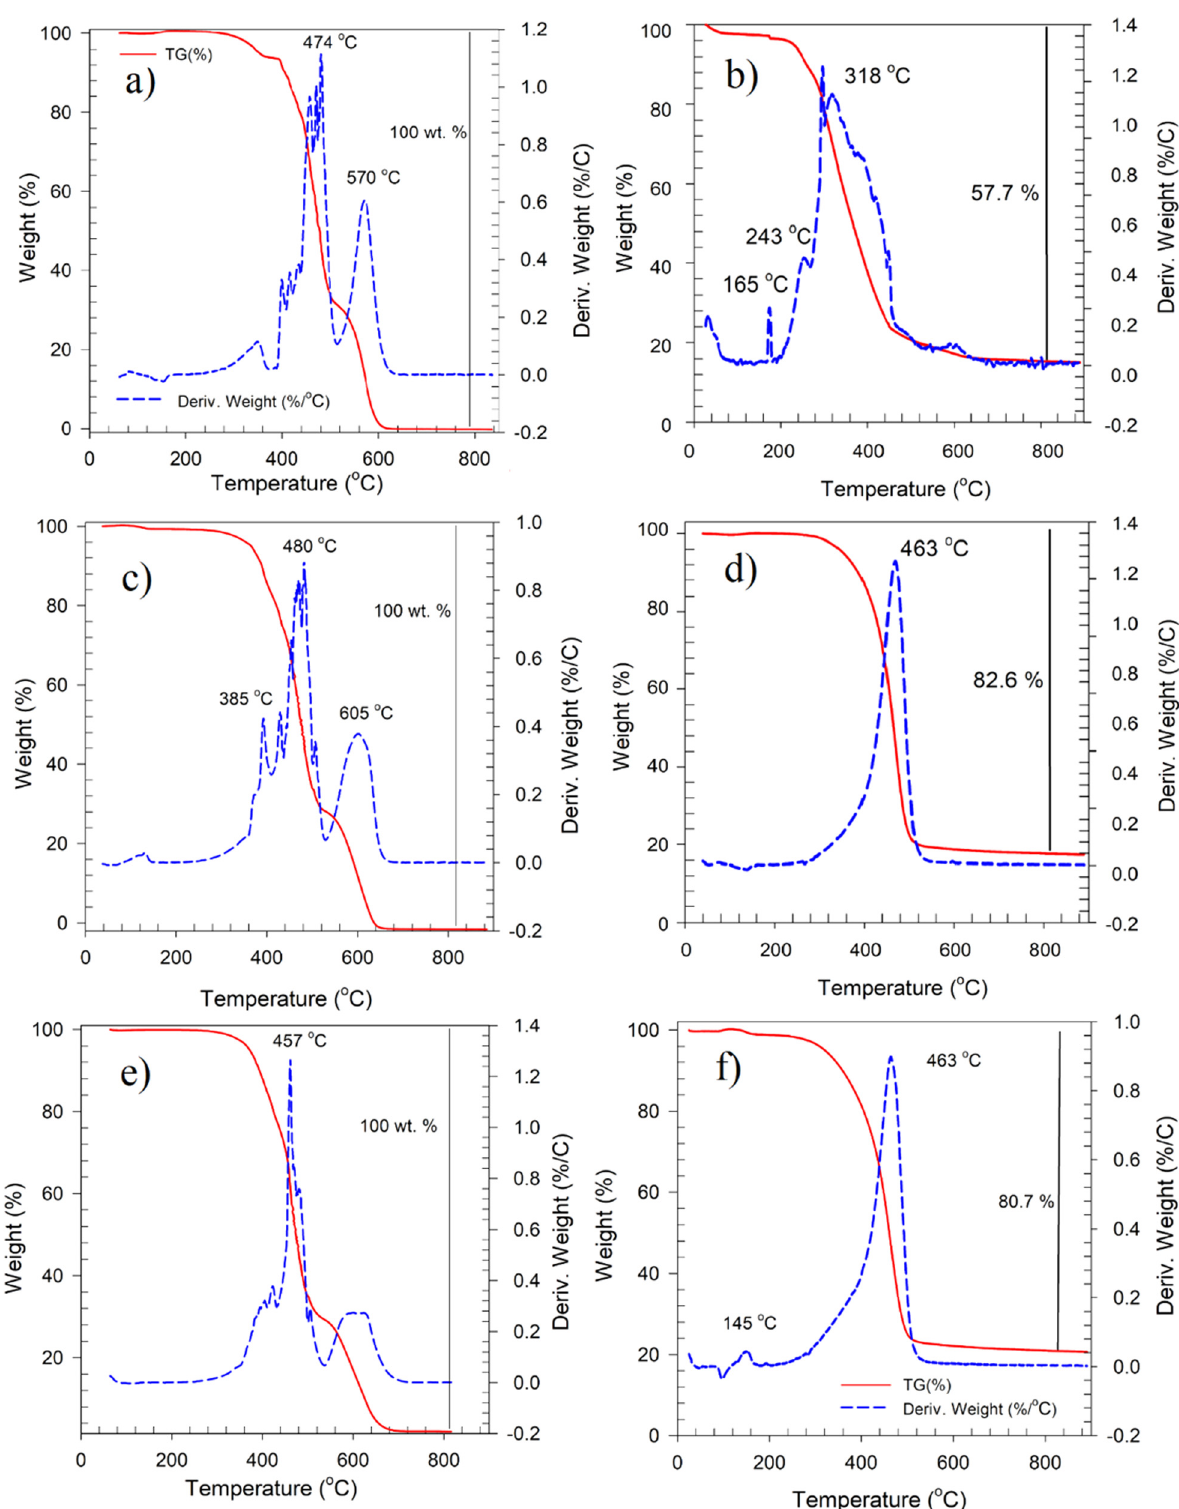
Figure 5: Derivative thermo - gravimetry and thermal gravimetric analysis images: unaged binder samples: ( a ) base samples and ( b ) CSNPs modi fi ed; short - term aged binder: ( c ) base samples and ( d ) CSNPs modi fi ed; long - term aged binder: ( e ) base sample and ( f ) CSNPs modi fi